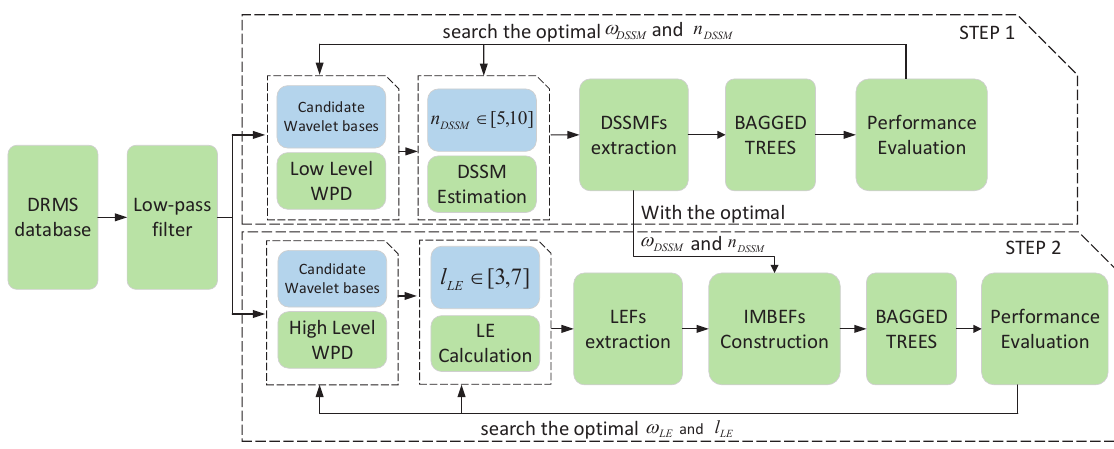
Figure 2. The diagram of the parameter optimization process. Table 6. The accuracy (%) of the two class sleep stage classification with different wavelet bases and different order of DSSM under R&K standard. Only DSSMFs are used, no LEFs.